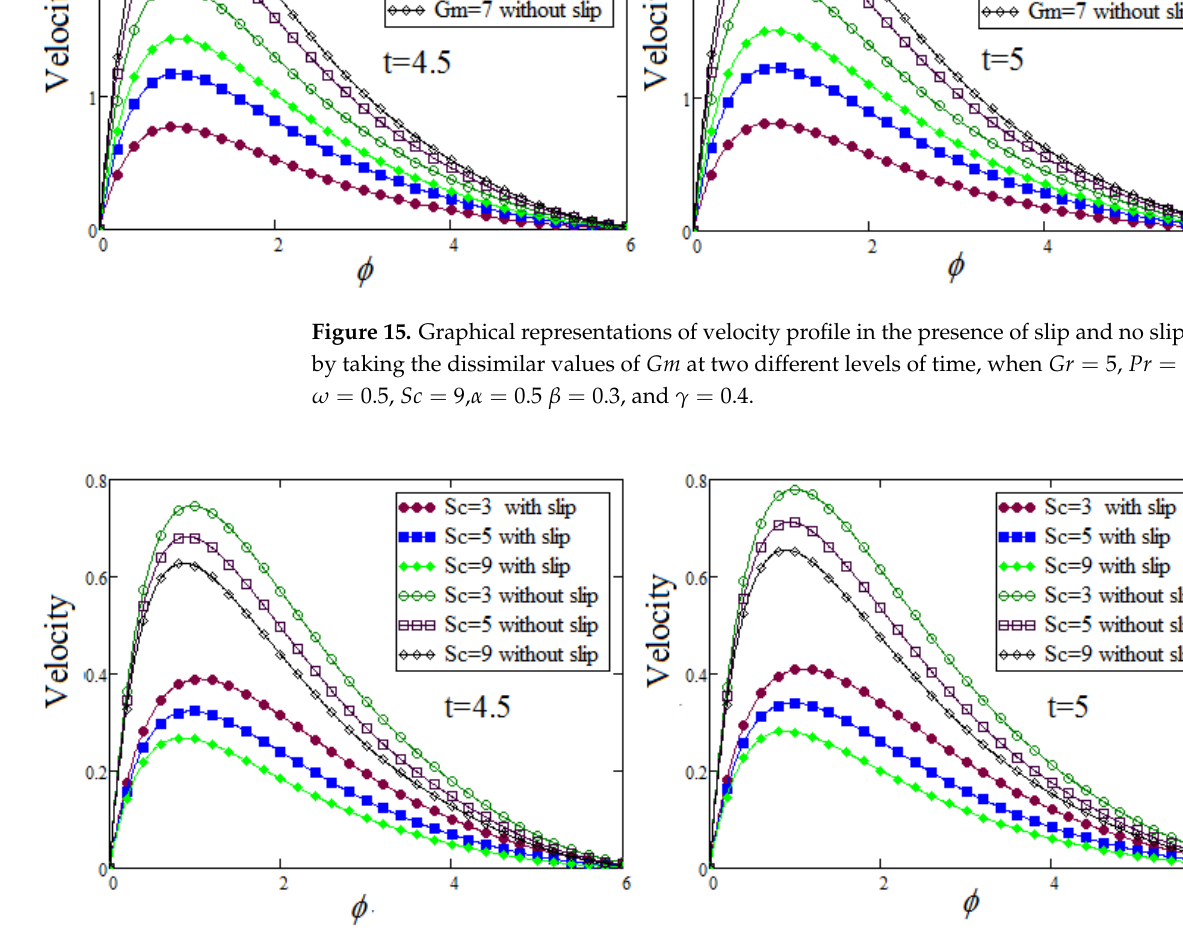
Figure 16. Graphical representations of velocity profile in the presence of slip and no slip conditions by taking the dissimilar values of Sc at two different levels of time, when Gr = 5, Gm = 3.5, ℘ = 0.4, ω = 0.5, Pr = 9, α = 0.5 β = 0.3, and γ =